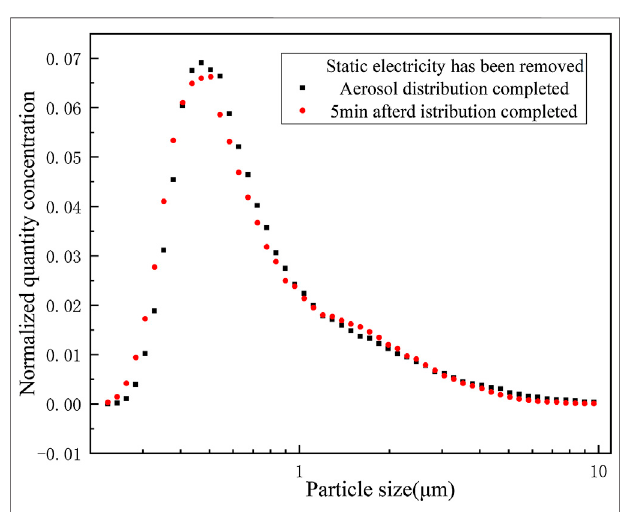
FIGURE 5 | Electrostatic effect on erosol distribution. Electrostatic removed.